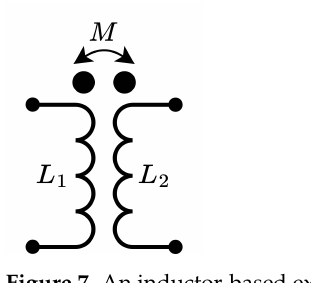
Figure 7. An inductor-based example of the concept of mutual coupling.